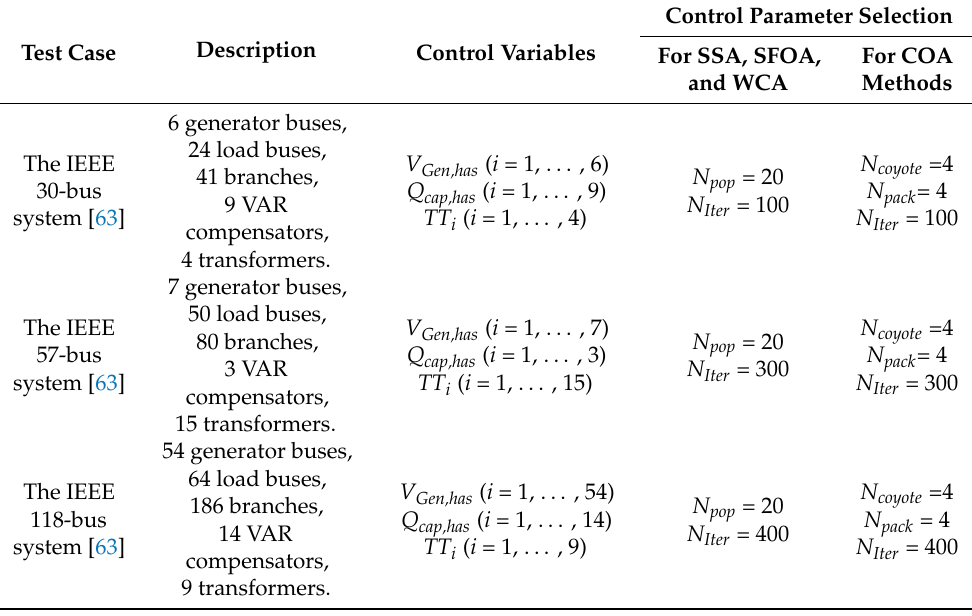
Table 1. The description of study cases and control parameter